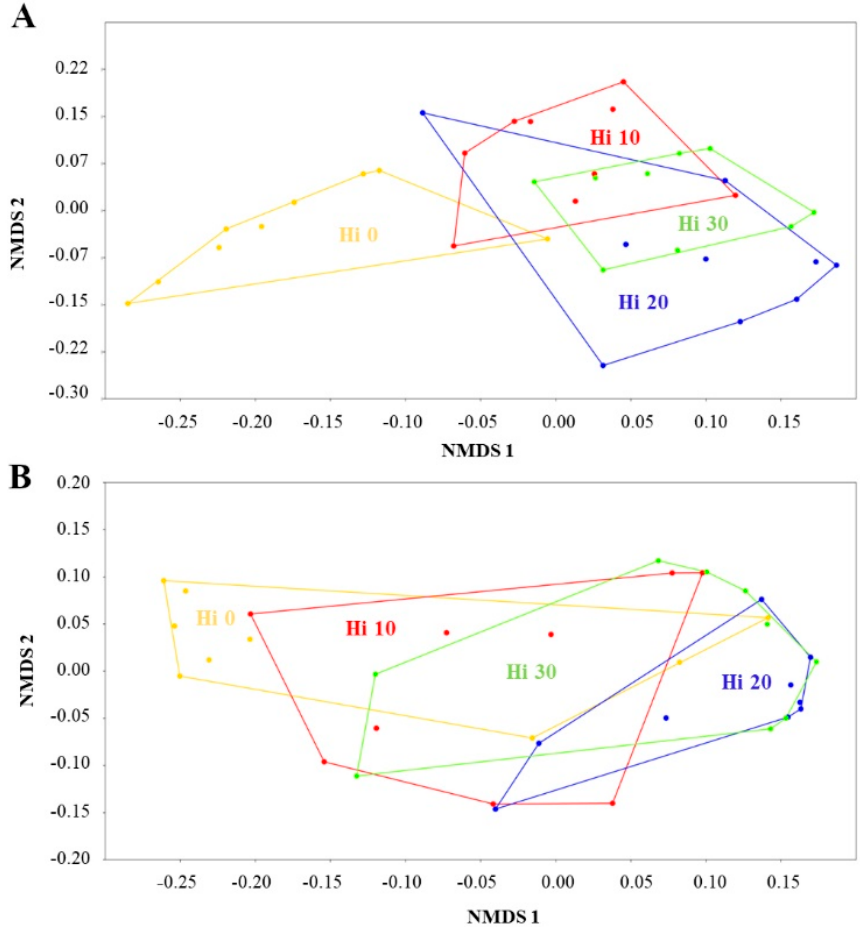
Figure 5. Non-metric multidimensional scaling (NMDS) with 2D Binary Bray–Curtis ( A ) and Bray–Curtis ( B ) index of bacterial OTUs found in intestinal mucosa samples of rainbow trout fed fishmeal (Hi 0) or H. illucens larvae meal (Hi 10, Hi 20, Hi 30) diets.